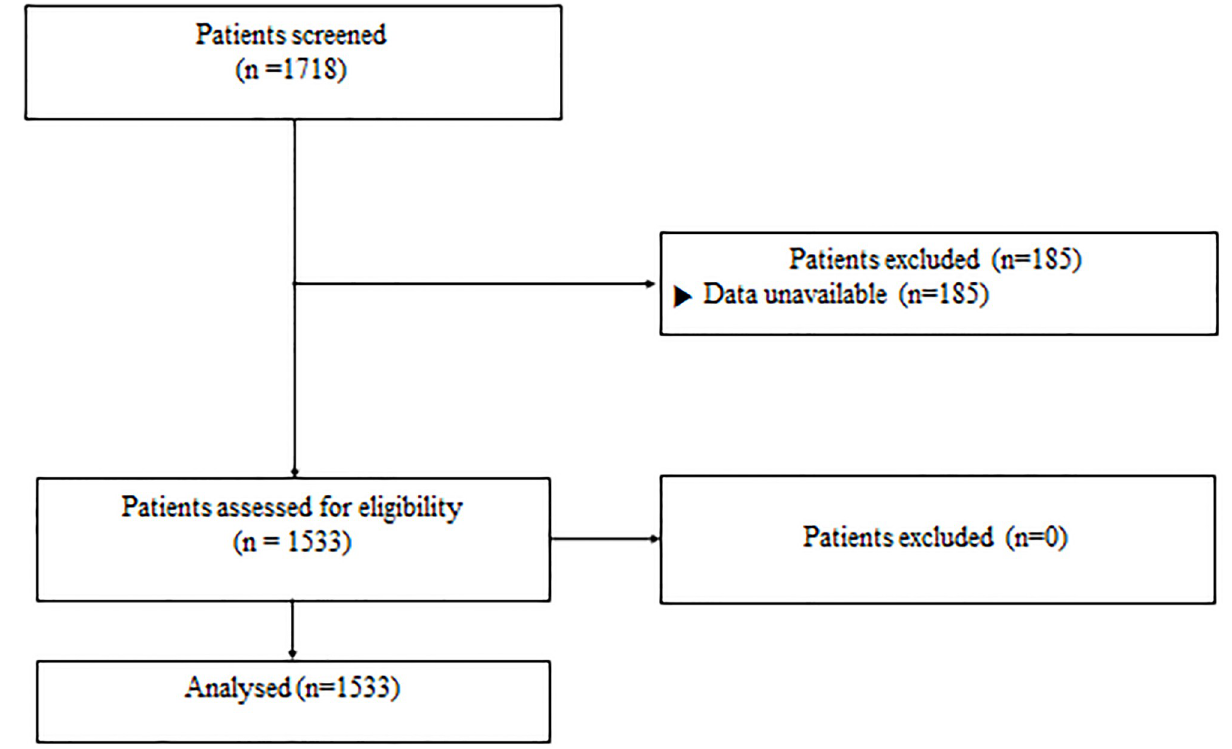
Fig 1. Flowchart of study